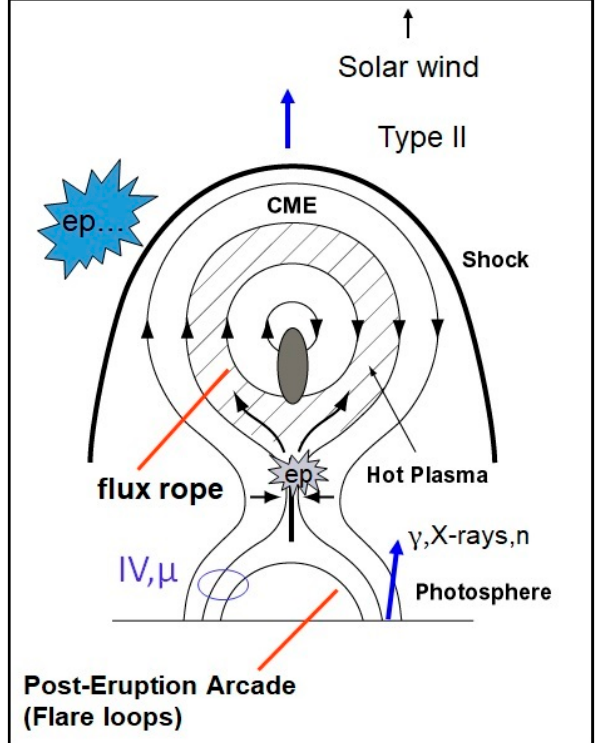
Figure 9. Schematic showing various aspects of a large solar eruption and particle acceleration. Two sites of particle acceleration are indicated by ep…, one being the flare reconnection site underneath the flux rope and the other in the shock front at the leading edge of the flux rope. The gray ellipse at the core of the CME flux rope is the eruptive prominence. Heated plasma and accelerated particles from the flare site enter the flux rope. Accelerated electrons trapped in the flux rope cause moving type IV bursts. Accelerated particles from the flare site also flow down towards the Sun causing hard X-rays (by electrons), gamma rays (by protons), and neutron emission (due to proton interac- tion with the chromosphere). Sunward electrons trapped in flare loops produce microwave bursts and stationary type IV bursts. Energy deposited in the chromosphere by the flare particles results in chromospheric evaporation making the flare loops hot and emit soft X-rays.